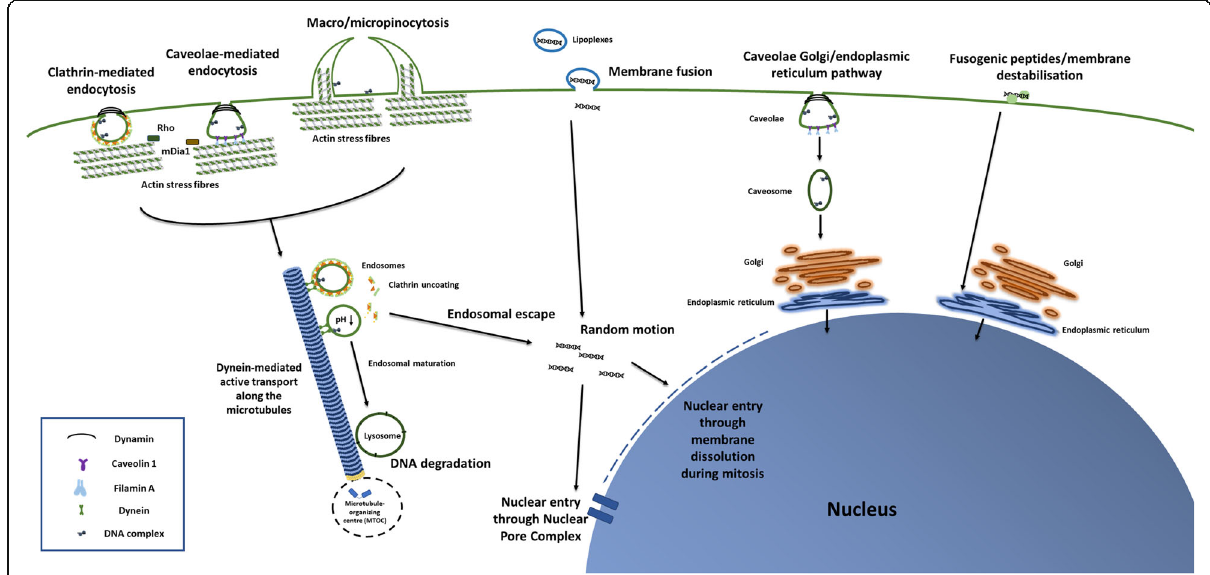
Fig. 1 Schematic representation of DNA endocytosis, cytoskeletal trafficking, and nuclear entry. Description of figure from left to right: DNA complexes enter the cells via endocytosis, through clathrin-coated vesicles, through caveolae or through pinocytosis. Their entry is regulated by Rho proteins and mDia1, which control actin dynamics. Dynamin mediates both clathrin-dependent and caveola-dependent endocytosis, whereas Caveolin 1 and Filamin A only mediate caveolae internalisation. Endocytic vesicles are transported by dynein and move along the microtubules. DNA complexes escaping the endocytic trafficking enter the nucleus. Nuclear entry either happens during cellular mitosis or through the Nuclear Pore Complex. A small portion of lipoplexes can enter the cells through direct membrane fusion. Certain caveolar vesicles were instead shown to directly target the Golgi, preventing DNA from reaching the lysosomes. Similarly, despite mechanisms being still obscure, certain CPPs can either fuse with or destabilise the plasma membrane, allowing the DNA to directly reach the Golgi-Endoplasmic Reticulum network, avoiding the lysosomal degradation [32 –